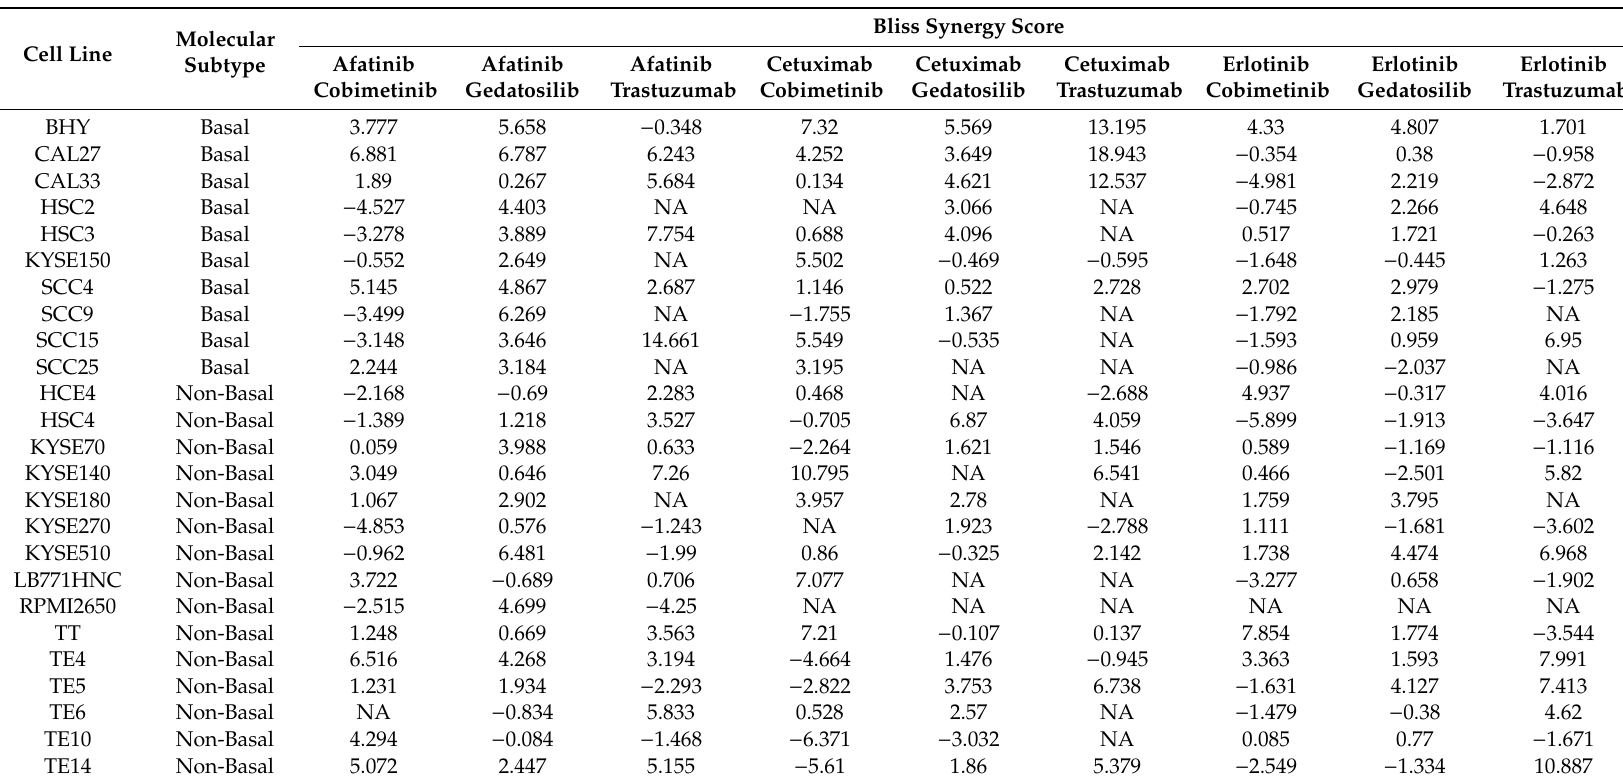
Table 2. Evaluation of the therapeutic e ffi ciency of drug combinations, as determined by Bliss synergy scoring models. The Bliss score for each drug combination is shown for the 25 HNSCC cell